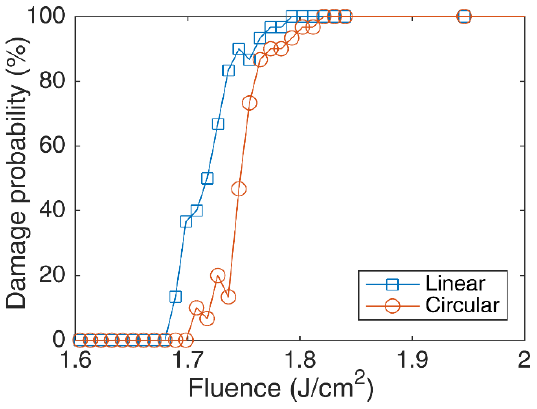
Figure 3. Damage probability with laser fluence at 1-on-1.